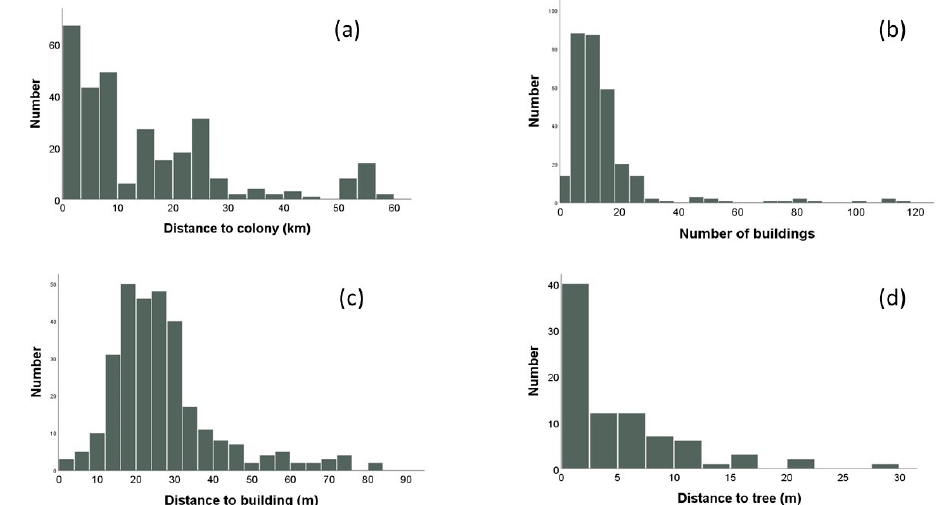
Figure 3. Number of flying foxes found electrocuted in relation to ( a ) their distance to the nearest known colony, ( b ) the number of buildings within a 100 m radius, ( c ) the distance to the nearest building, and ( d ) to the nearest cultivated fruiting tree.